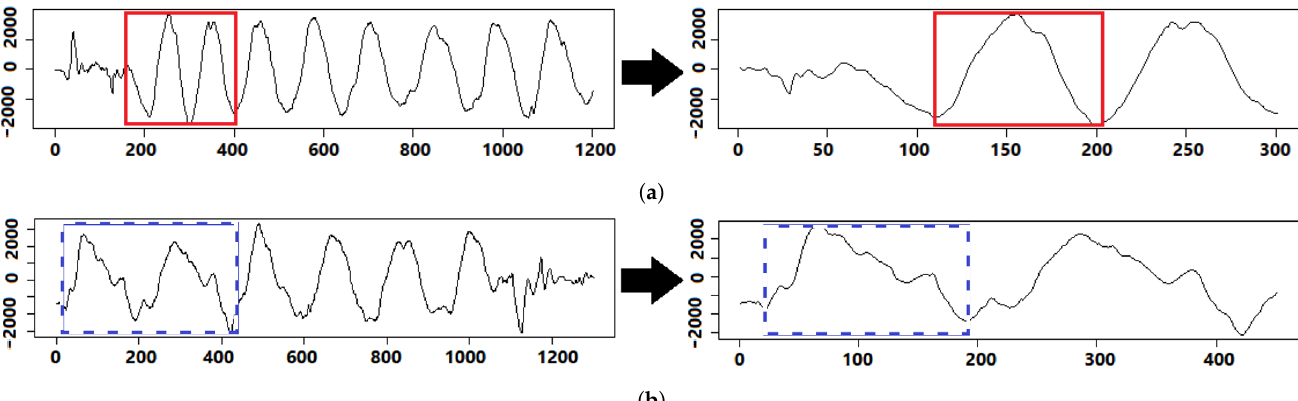
Figure 3. Raw bicep repetitions data collected from the X -axis of the gyroscope. Red thick boxes highlight repetitions without fatigue, while blue dashed boxes highlight repetitions with fatigue. ( a ) Extracting non-fatigue bicep concentration curl repetitions from the fifth set. ( b ) Extracting fatigue bicep concentration curl repetitions from the fifth set.